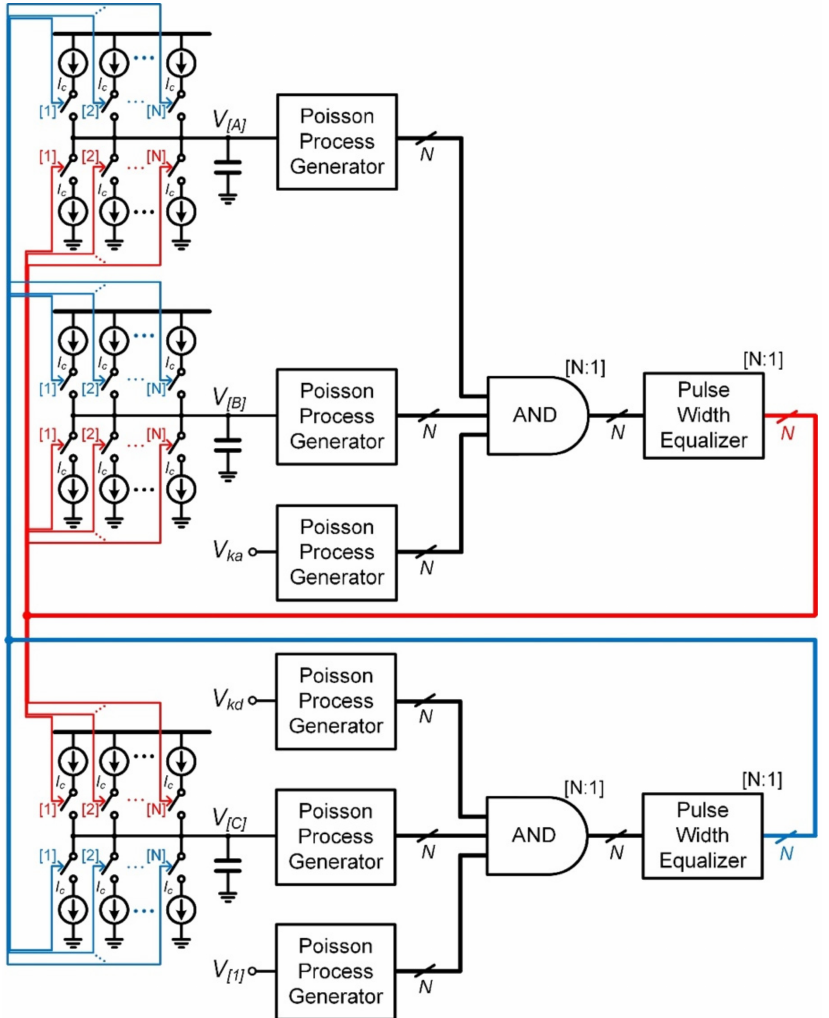
Figure 5. Fundamental reaction building block for stochastic simulation of bidirectional second-order reaction: A + B ↔